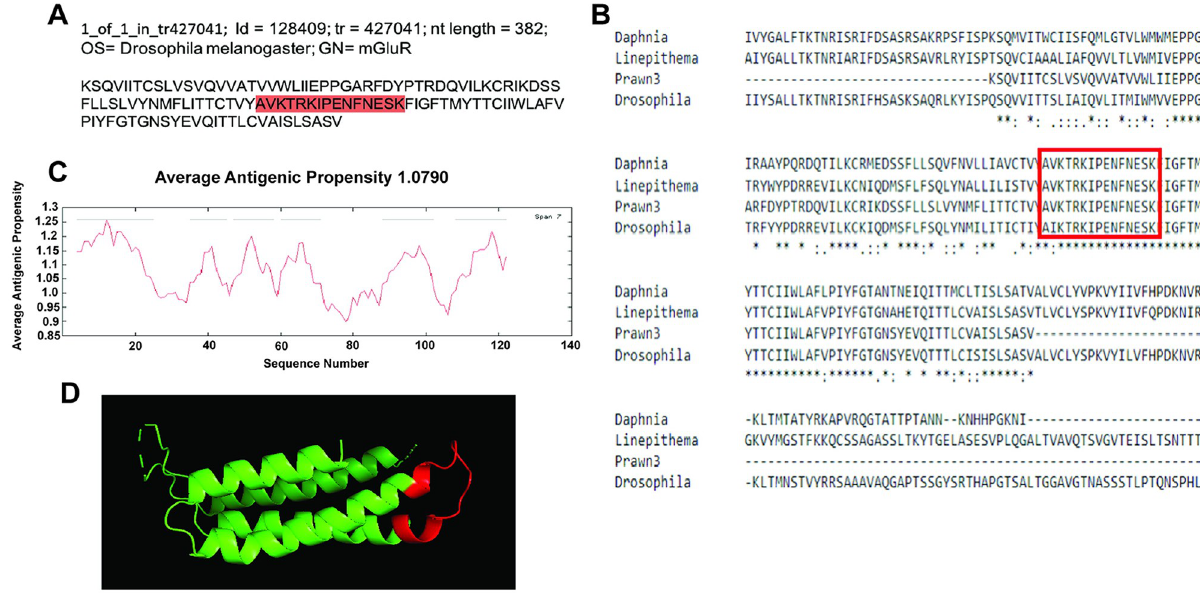
Fig 3. Contig annotated as metabotropic glutamate receptor 1 (mGluR1) analysis for antibody production. A) Contig identifiers for mGluR1 in the M . carcinus transcriptome and its sequence translated into amino acids for further analysis. B) Multiple sequence alignments of the prawn´s contig were compared to the same protein in other species: branchiopod D . pulex , insect L . humile , and the fruit fly D . melanogaster . Regions of conserved amino acids are shown within the red box. C) Average antigenic propensity value was 1.0790, showing 6 determinants (peaks in graph) within the sequence that are good candidates for antigenic response. D) A 3D reconstruction model showing tertiary structures of the prawn mGluR1 contig sequence. The red highlight in A, rectangle in B, and segment in D represent the selected sequence for antibody production.